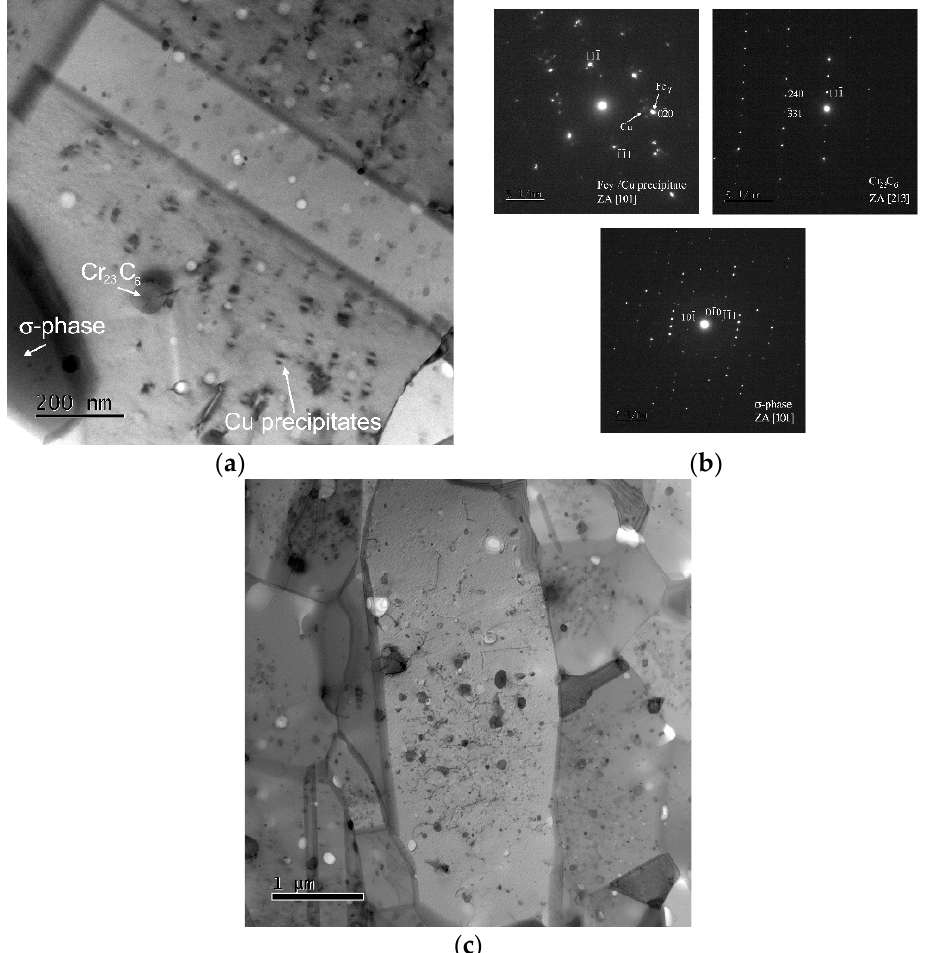
Figure 9. TEM micrographs for HPS-processed steel tested at ( a ) 700 °C and 30 MPa, ε = 0.1, creep time ~ 65 h; ( b ) diffraction patterns of Cu precipitate, Cr 23 C 6 carbide and σ -phase, ( c ) 700 °C and 30 MPa, ε = 0.4, creep time ~ 235 h.